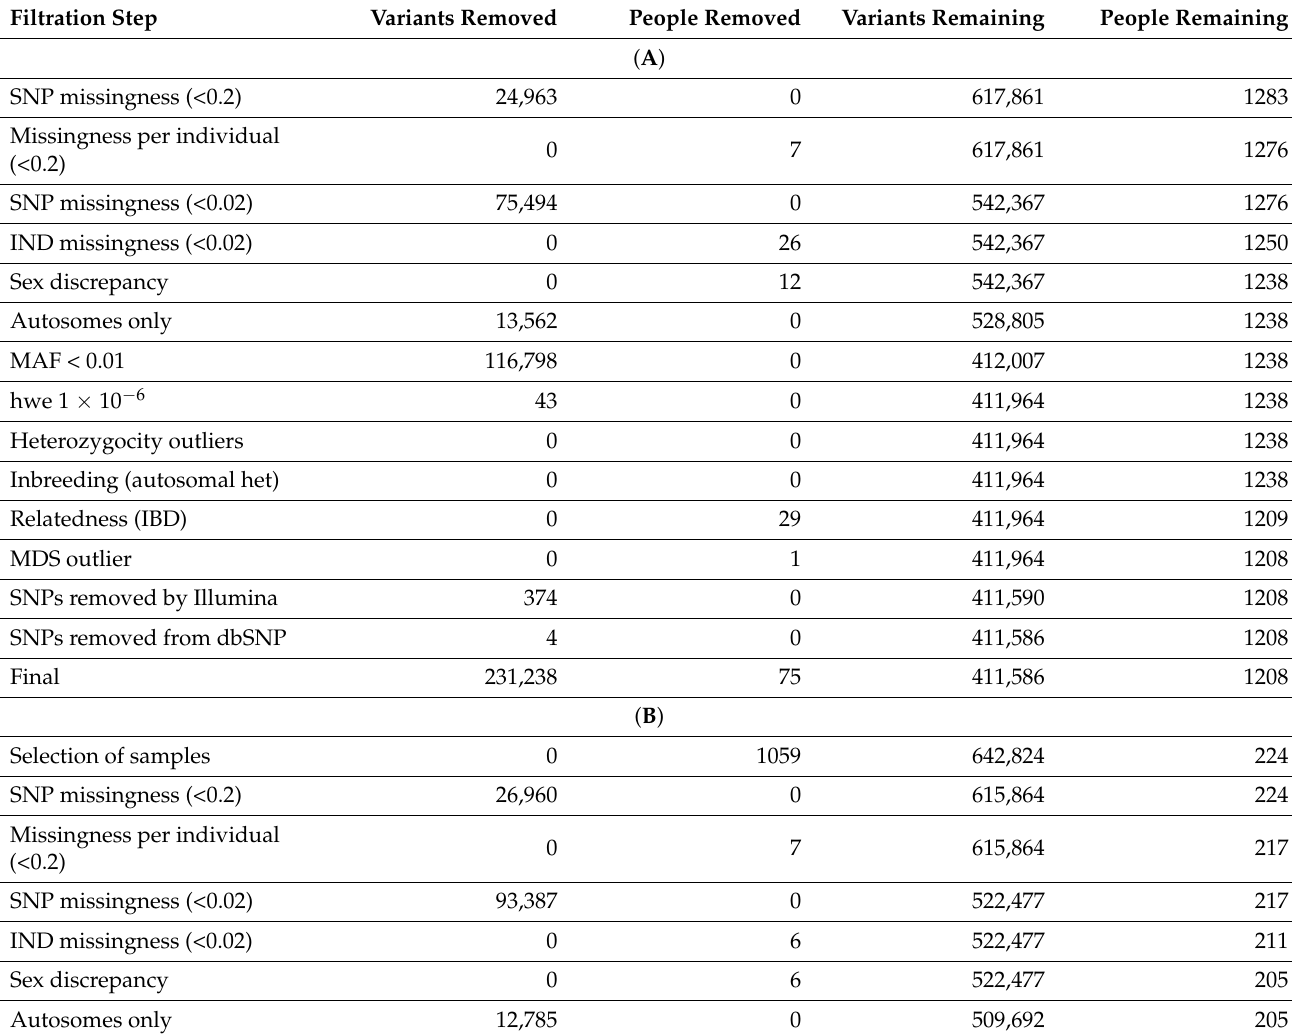
Table 2. (A) The sequential QC procedure for cases and controls. (B) The sequential QC procedure for cases